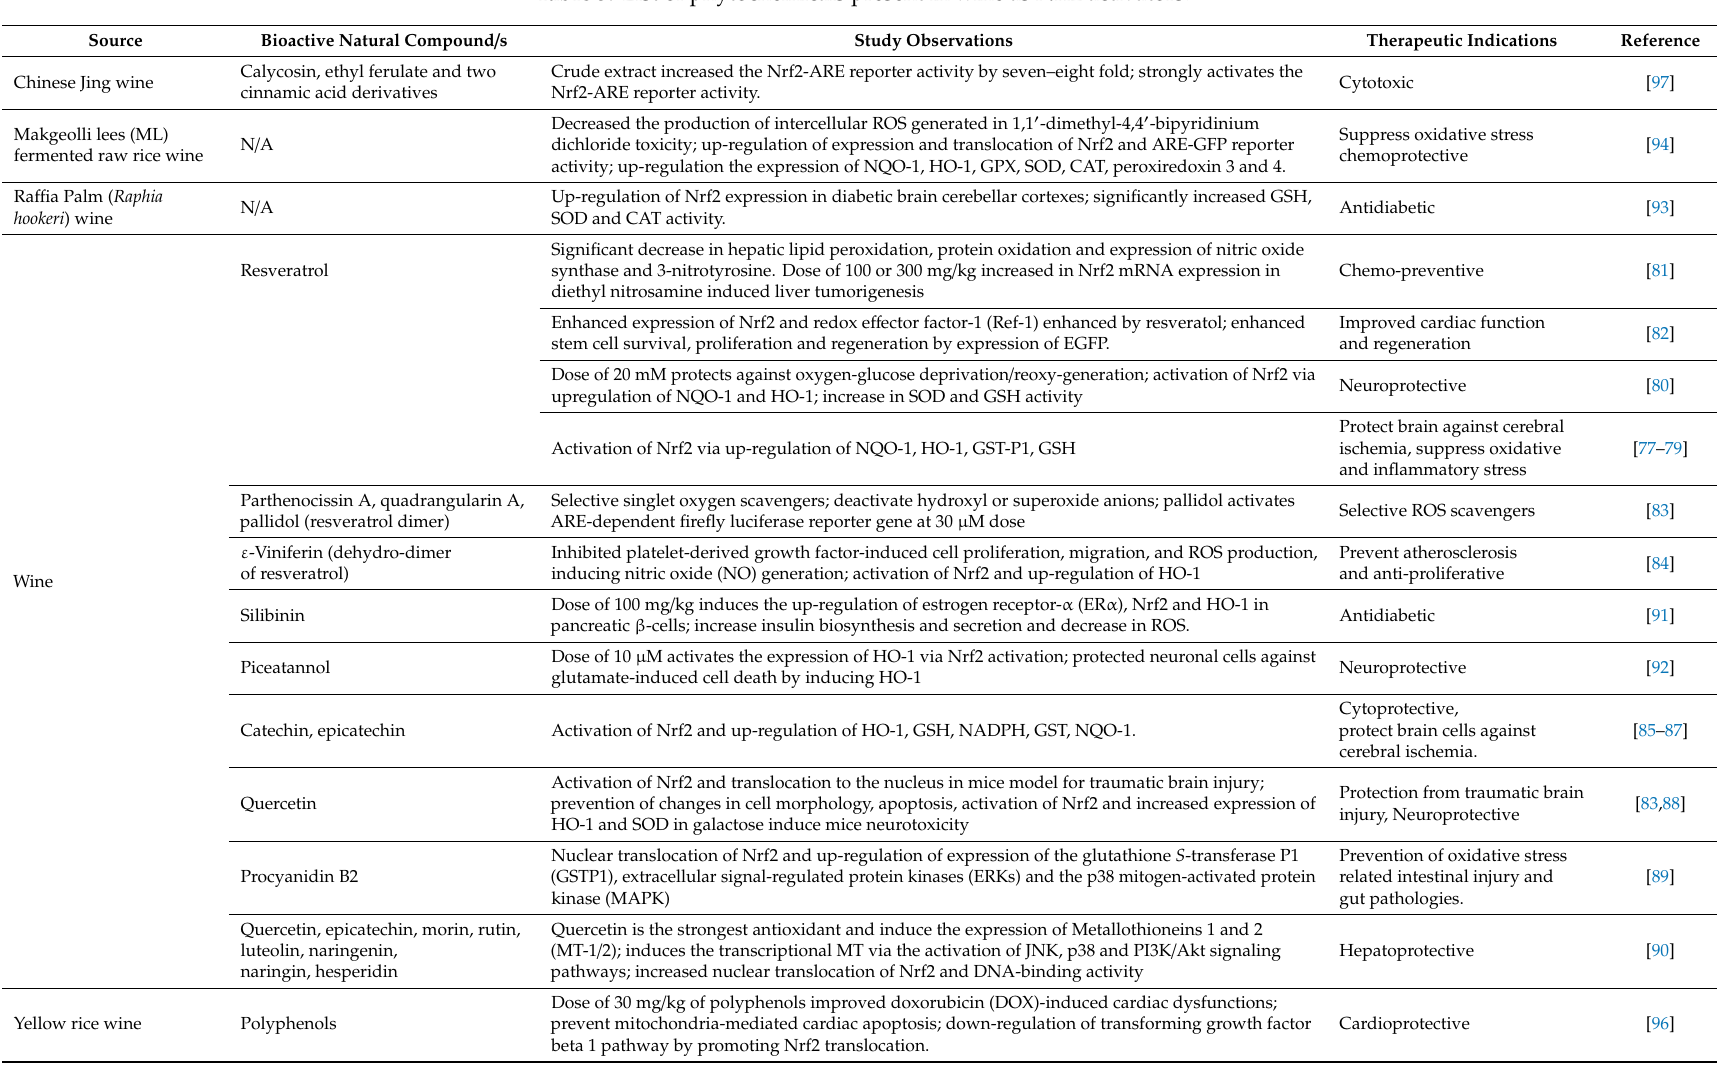
Table 3. List of phytochemicals present in wine as Nrf2